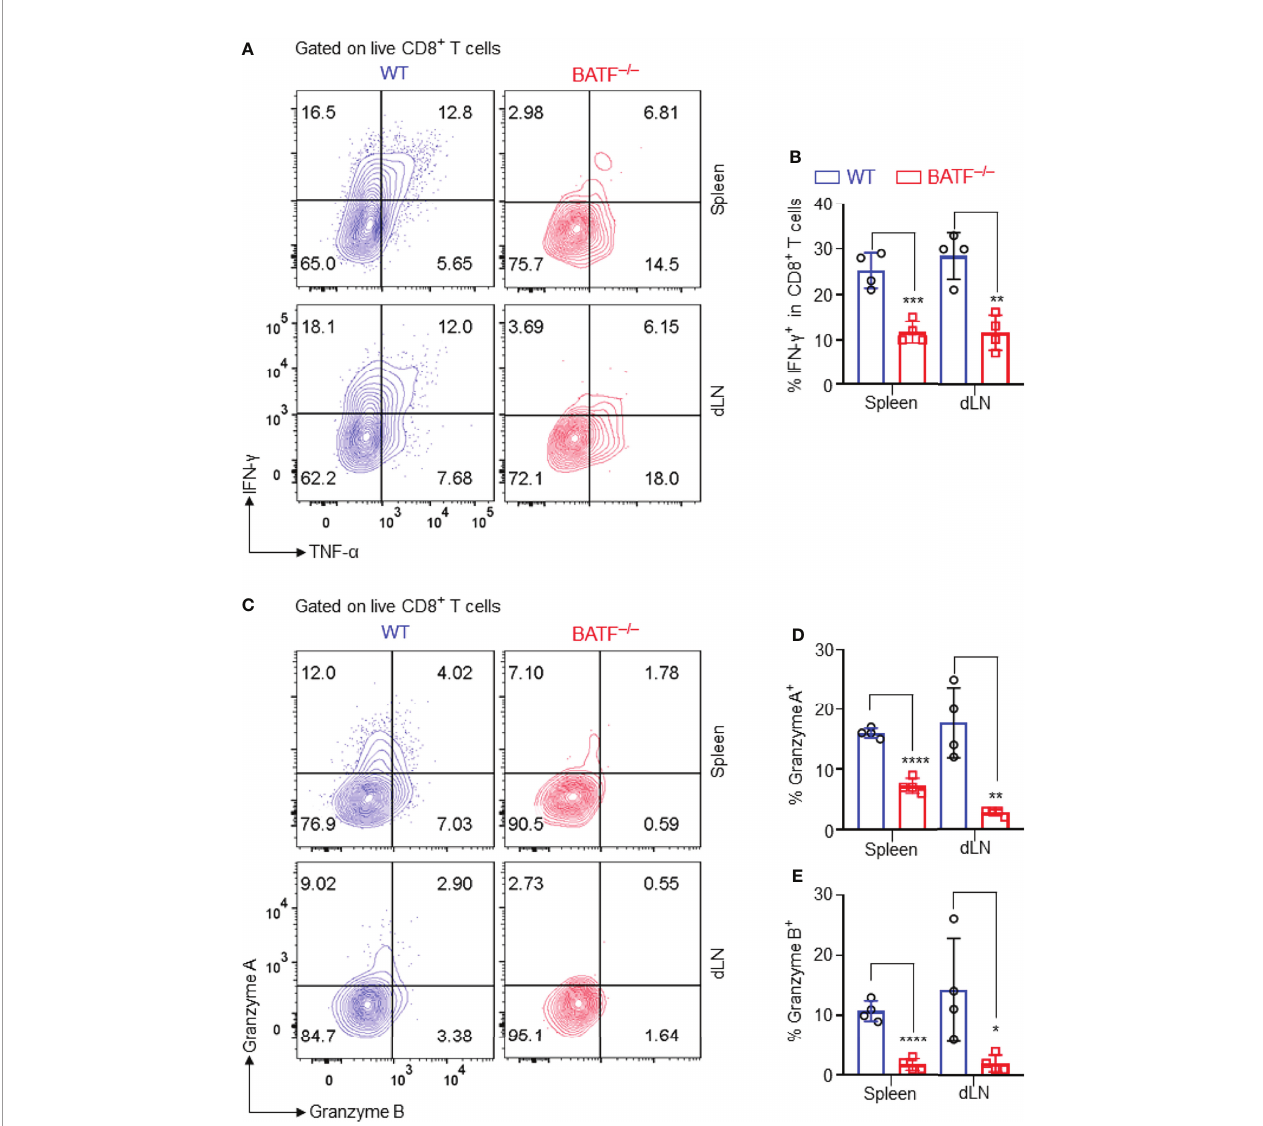
FIGURE 4 | BATF de fi ciency in CD8 + T cells impairs their expression of proin fl ammatory cytokines and cytotoxic molecules. The production of the effector cytokines and cytotoxic molecules of the adoptively transferred CD8 + T cells in recipients were analyzed on day 11 post skin grafting. All plots were gated on live CD8 + T cells. (A, B) Representative plots and bar graph display % IFN- g + cells in spleens and dLNs. (C – E) Representative plots and bar graphs display % Granzyme A + cells and % Granzyme B + cells. Data represent the mean ± SD (n = 4). * p < 0.05, ** p < 0.01, *** p < 0.001, **** p < 0.0001; (unpaired Student ’ s t